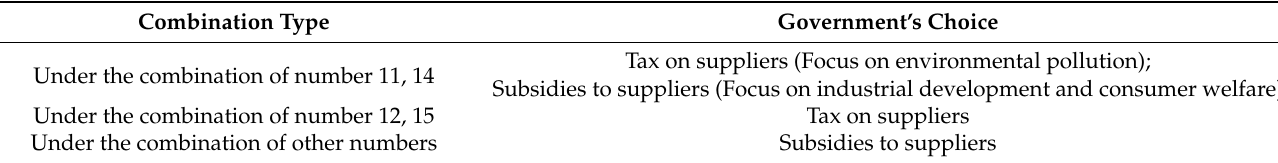
Table 6. The government’s